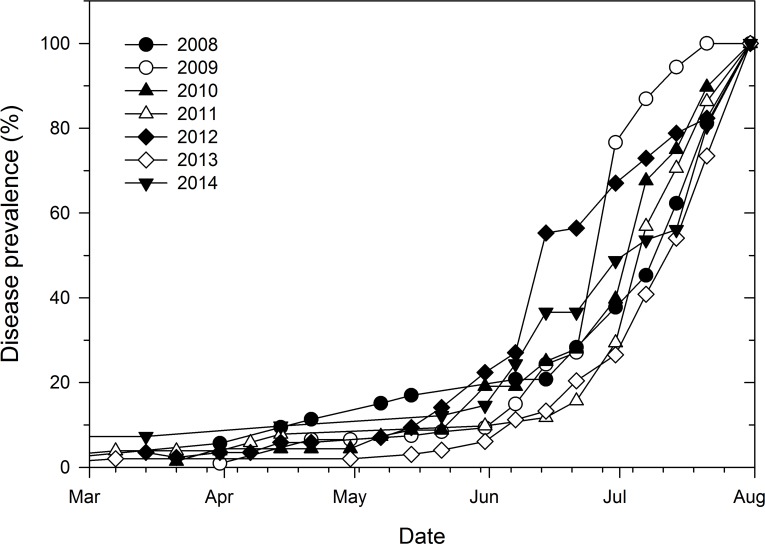
Temporal prevalence of cucurbit downy mildew in the eastern United States based on county-level reports of disease outbreaks.Prevalence of cucurbit downy mildew in the eastern United States based on cumulative number of counties with disease reports as a proportion of the final number of counties with disease outbreaks in each epidemic year.